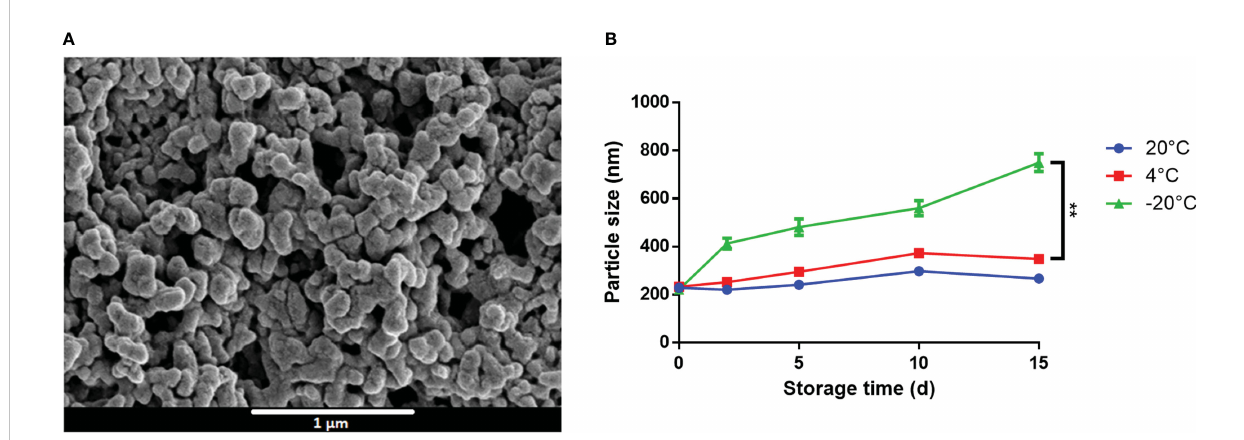
FIGURE 2 M7 and CpG form stable self-assembled NPs. (A) SEM micrographs of M7-CpG NPs (N/P ratio = 1) and (B) DLS particle size of M7-CpG NPs (N/P ratio = 1) over time at different temperatures. Data are presented as mean ± standard deviation ( n = 3). Signi fi cant differences were determined using a two-way ANOVA test with Tukey ’ s multiple comparison (** p -value ≤